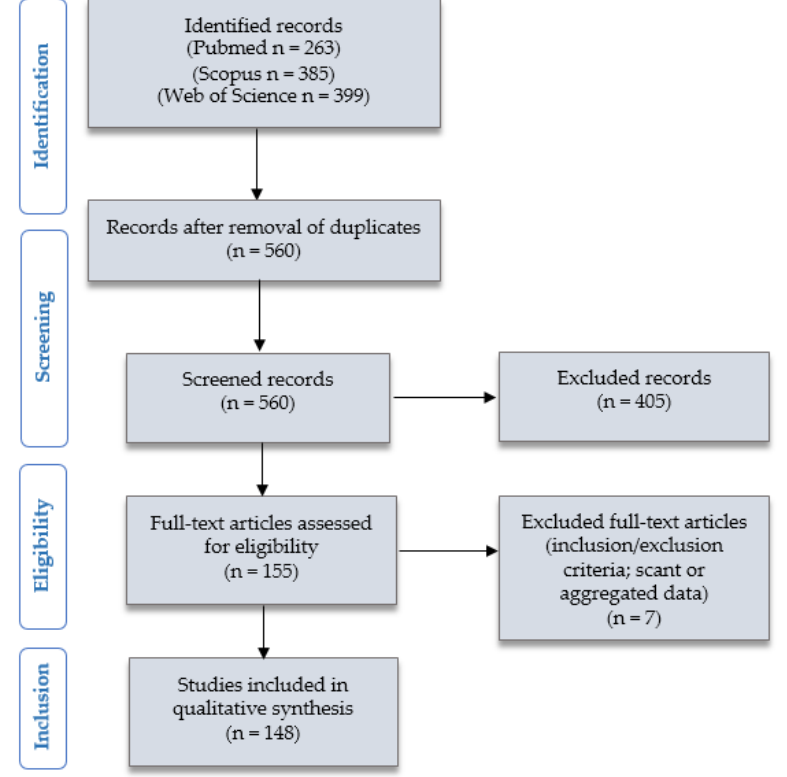
Figure 1. Review of the literature: PRISMA flow-chart.